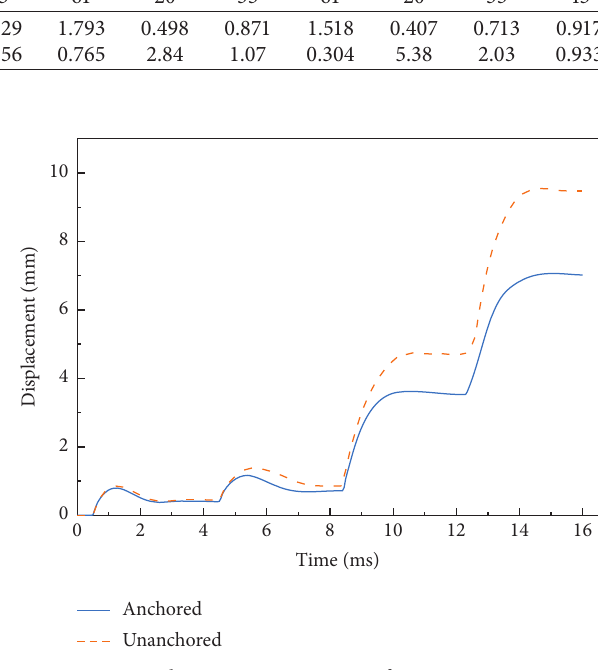
Figure 8: Displacement-time curves of measuring point